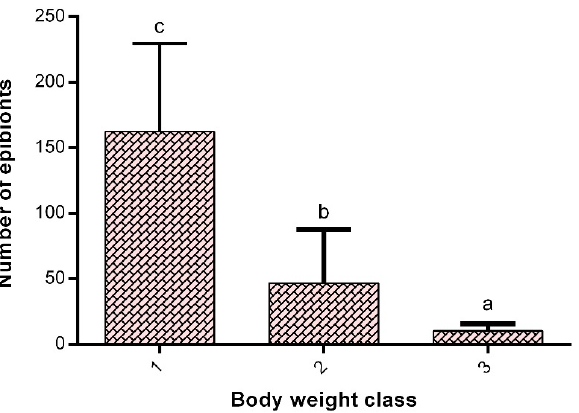
Figure 3. Crayfish body weight s and the number of branchial epibionts. Class 1: 0.2–0.6 g (n = 30), 2: 0.7–1.1 g (n = 27), and 3: 1.2–1.6 g (n = 23). Different letter between bars indicates significant difference ( p < 0.05).